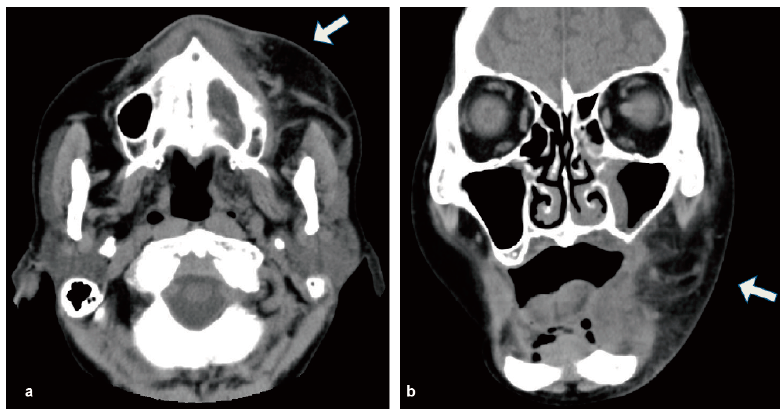
Figure 1. Enhanced CT revealed the soft tissue swelling widely extended to the left submandibular space without abscess formation (arrowhead). ( a ) Axial scan; ( b ) coronal scan.